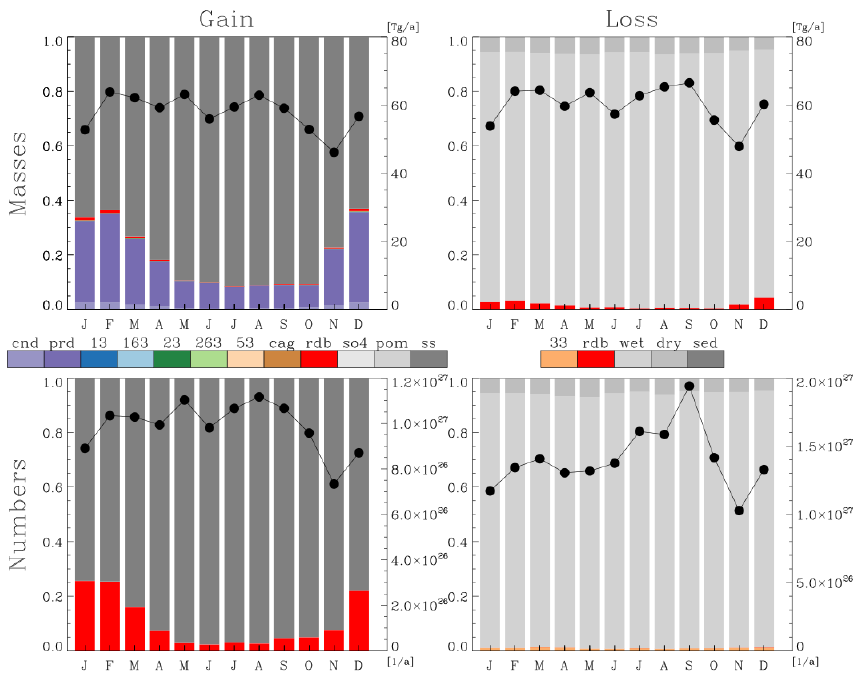
Figure 19. Seasonal cycle of regional tendencies of the hydrophilic accumulation mode over the Southern Ocean (see Fig. 1). The colored bars show fractional tendencies (left axis) for the processes defined in Table 2. The solid line (right axis) shows the total